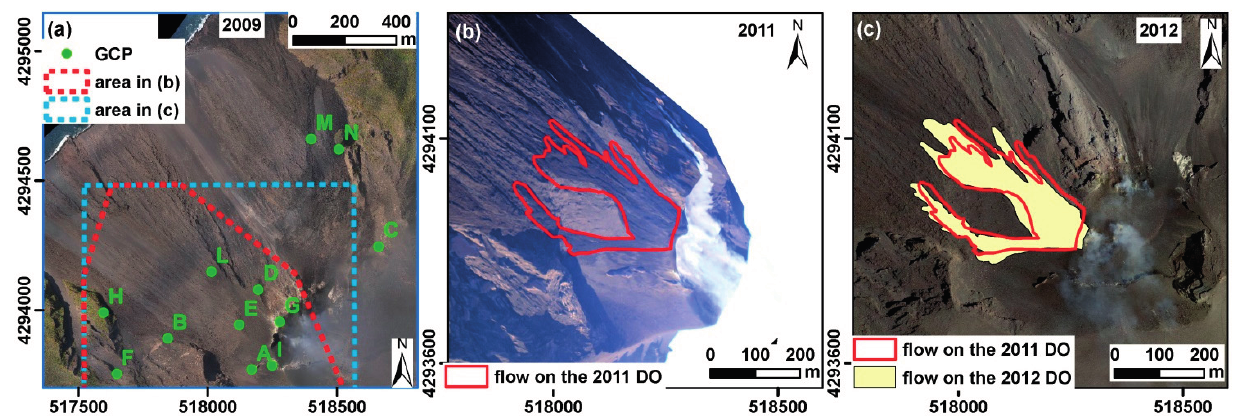
Figure 10. Test 4—2010 overflow at Stromboli: ( a ) 2009 orthophoto of Sciara del Fuoco slope and natural points selected as GCPs; ( b ) Limits of the December 2010 overflow defined on 25 January 2011 DOs; ( c ) Limits of the December 2010 overflows defined on the on the 2011 DOs (red line) and on the 2012 (yellow polygon), the background image is the 2012